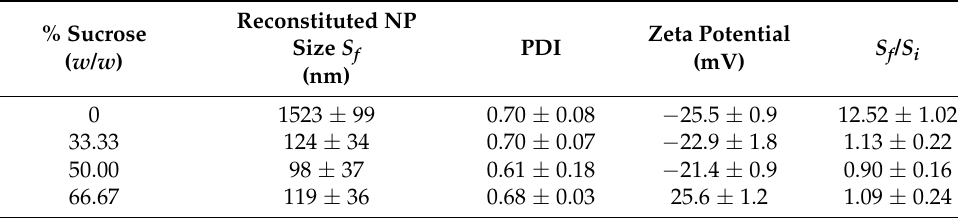
Table 2. Aqueous reconstitution of the lyophilized CUR-BSA nanoplexes prepared at different sucrose mass fractions after 30-day exposures at 40 ◦ C and 75% RH.